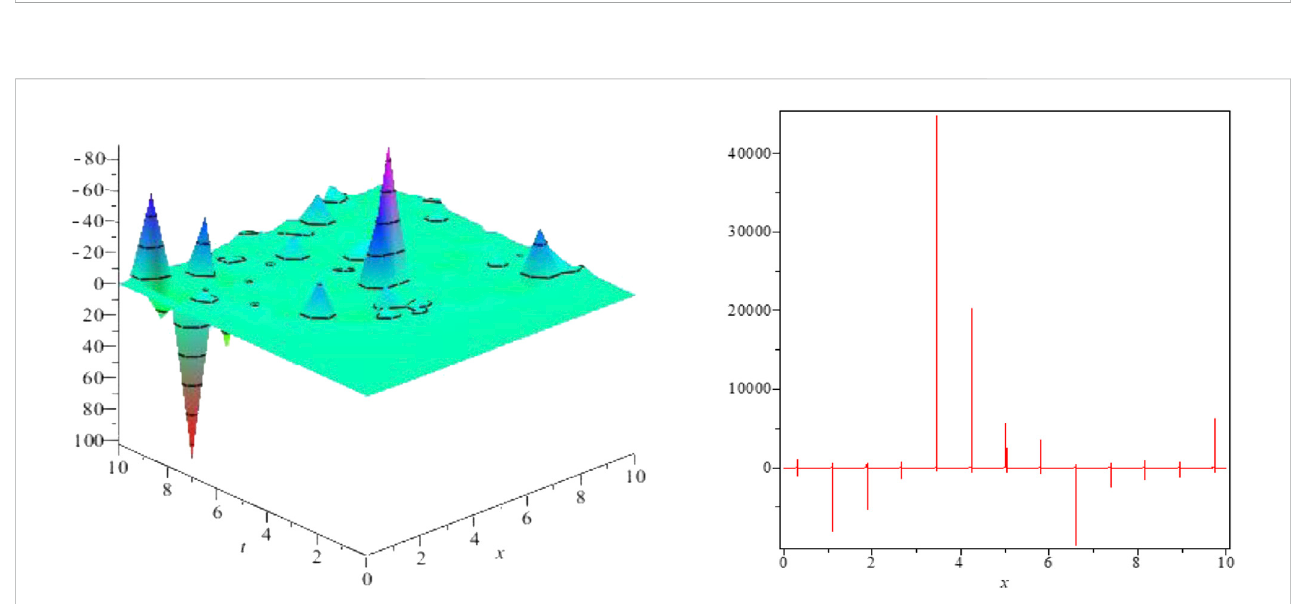
, γ ( x , t ) (cid:2) 20 −( xt ) 4 , δ ( x , t ) (cid:2) 15 + sin 6 ( xt ) , α (cid:2) 4 , β (cid:2) 5 , σ (cid:2) − 3 , t (cid:2) 1. 50 50 2